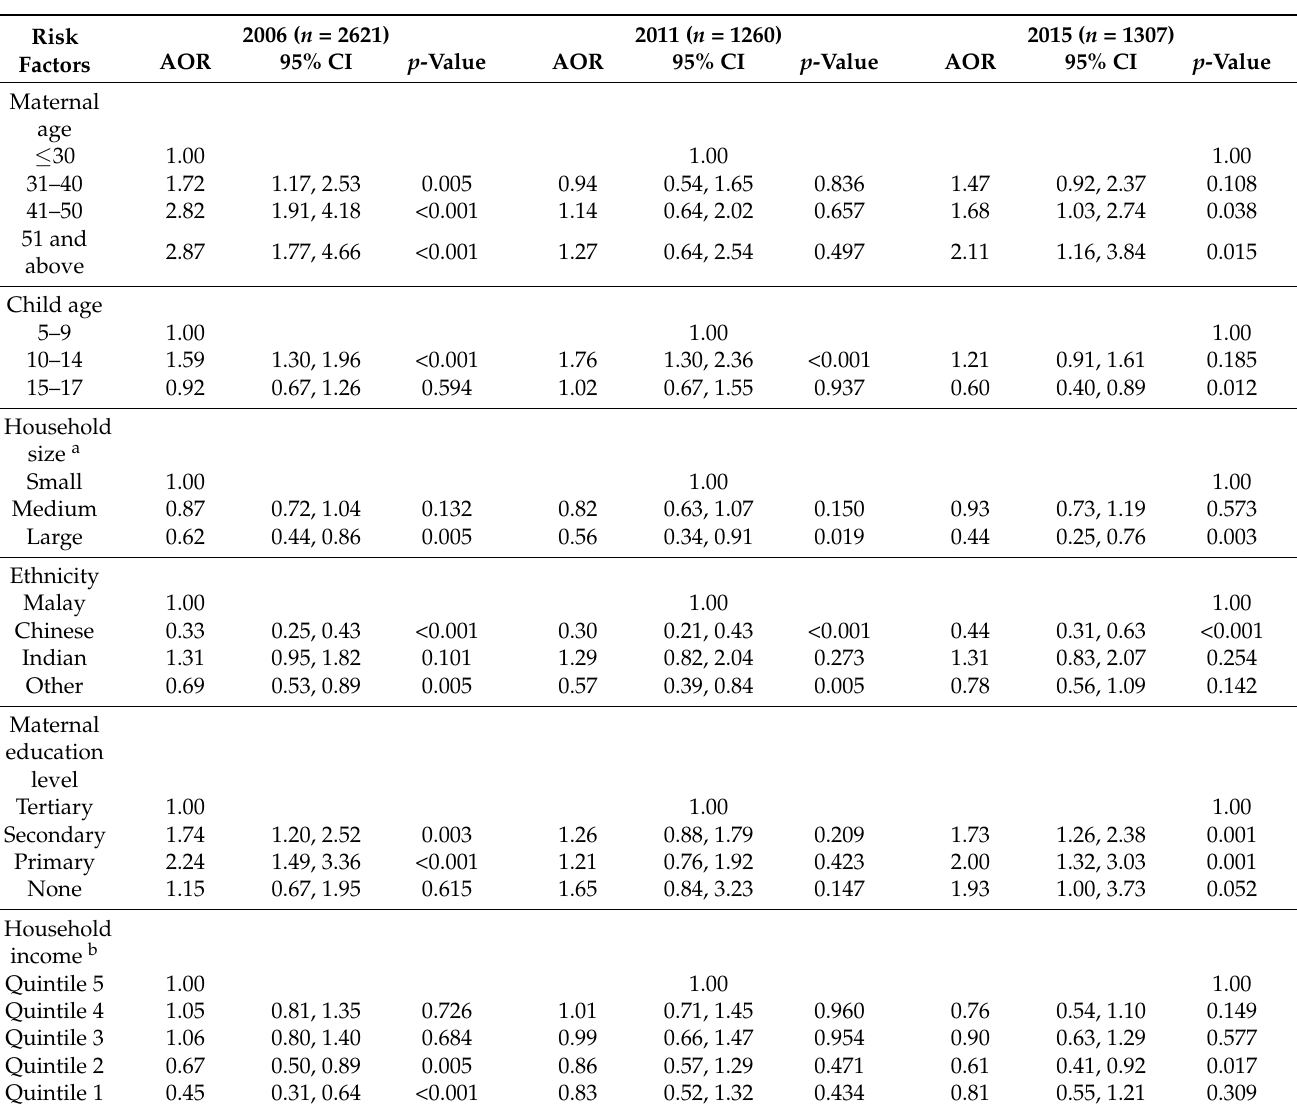
Table 5. Multivariable logistic regression analysis for the factors associated with overweight mother/overweight child pairs in Malaysia for 2006, 2011 and